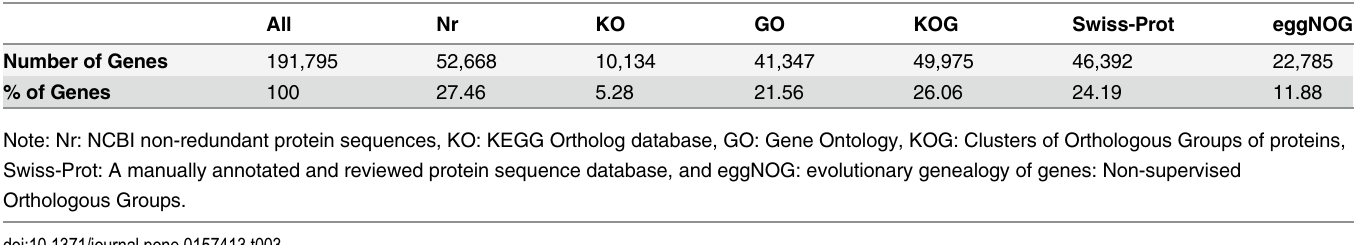
Table 3. Statistics of the annotation results for the C . idella